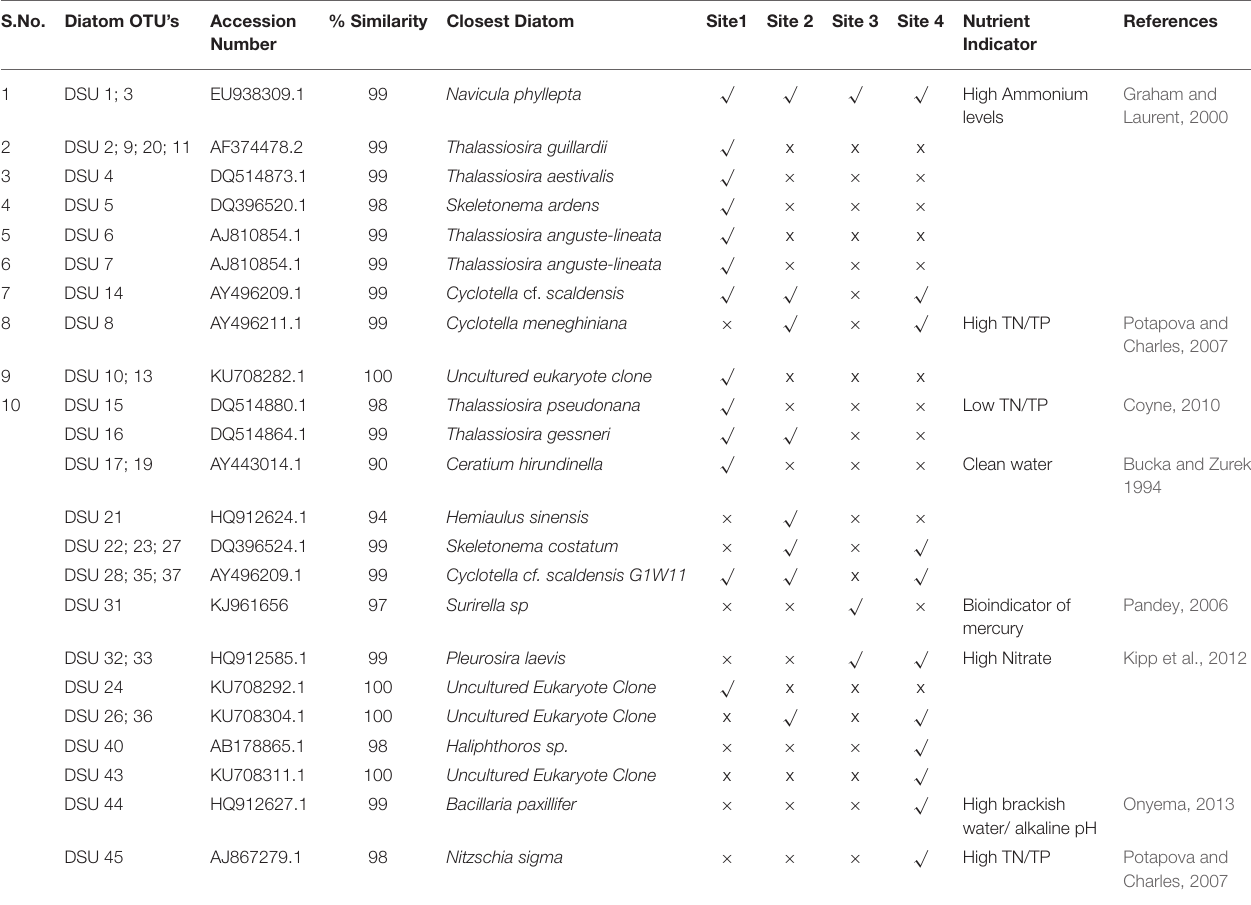
TABLE 4 | Identification of diatom Operational Taxonomic Units (OTU’S) from the study sites, accession numbers, and similarity percentages of closely matched diatom species from the Genbank database has been displayed next to the OTU’s. S.No. Diatom